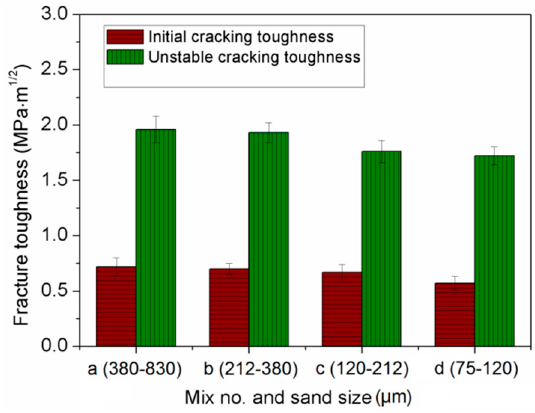
Figure 12. Fracture toughness of cement-based composites.